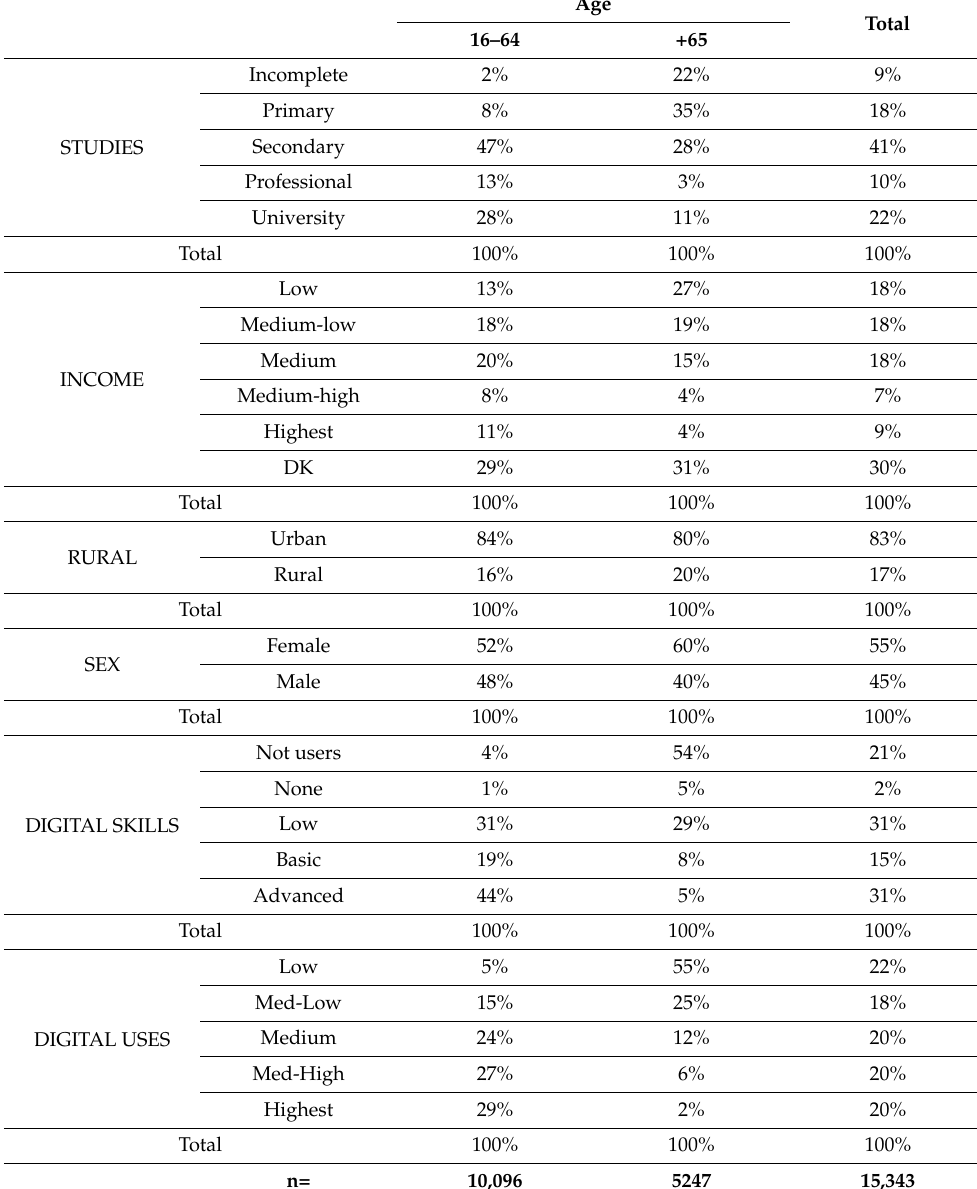
Table 1. Differences between the seniors and the general